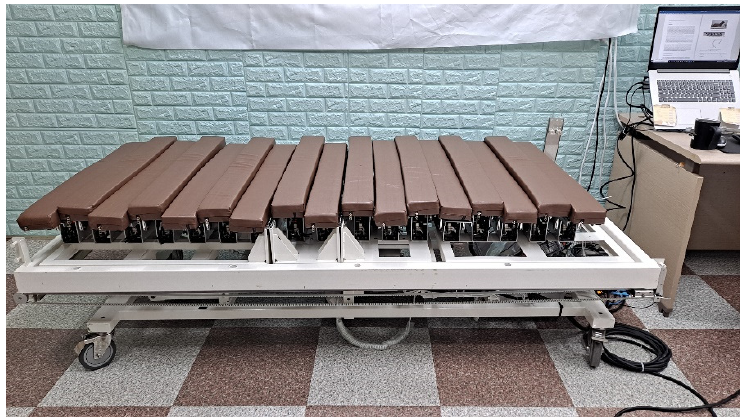
Figure 15. Open-loop control experiment result.